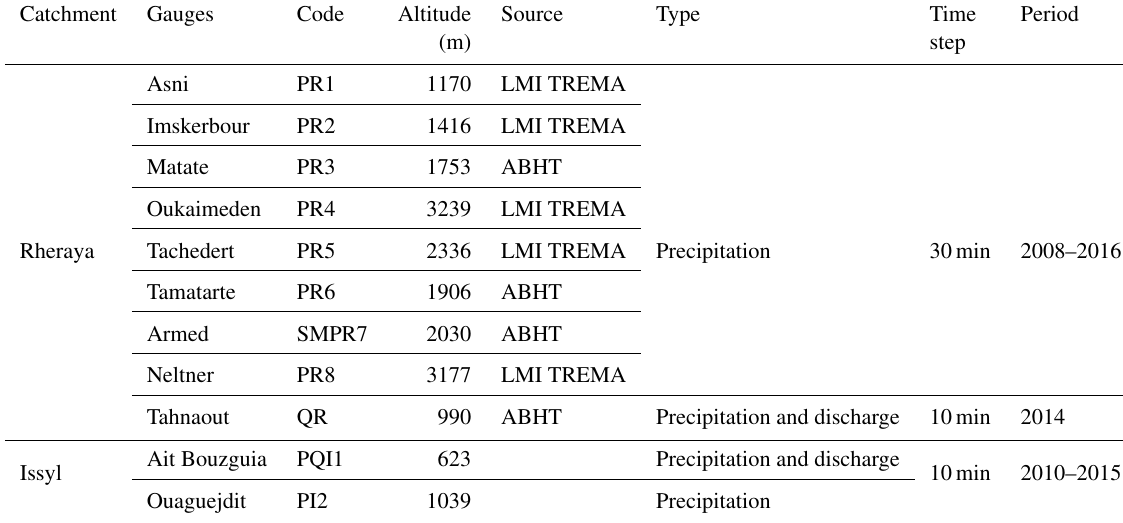
Table 1. Stations with observed precipitation and river discharge.